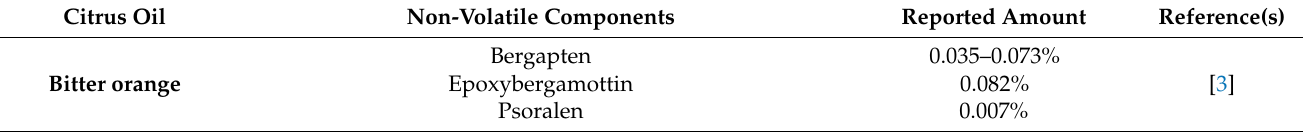
Table 3. Non-volatile components of cold-pressed Citrus oils that are reported in the